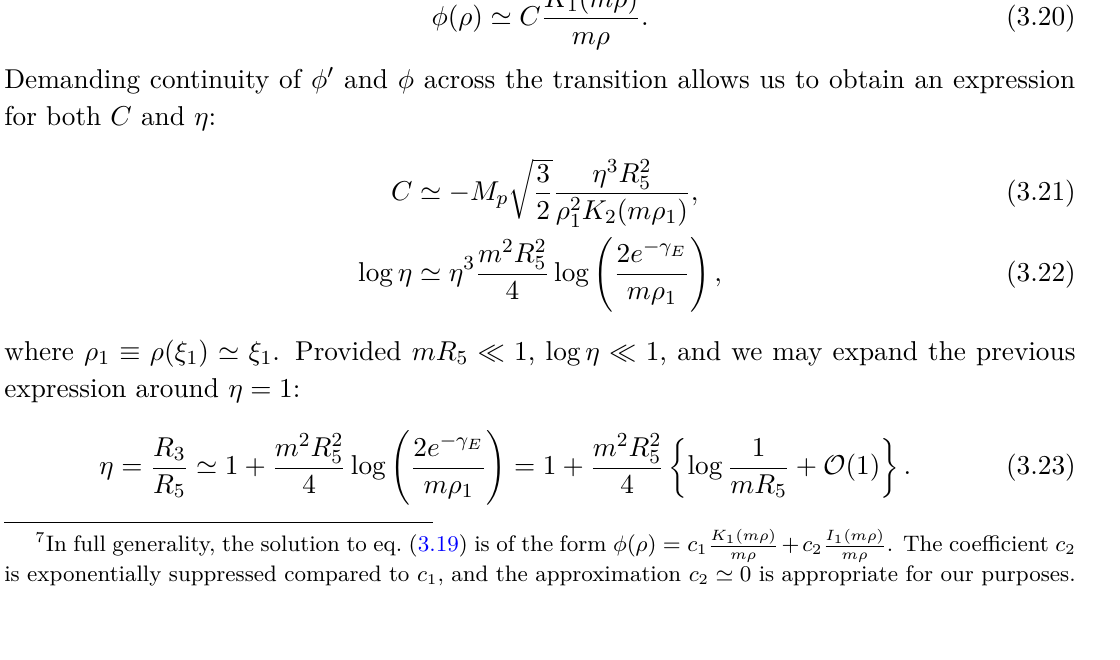
Figure 4: Diagram R5